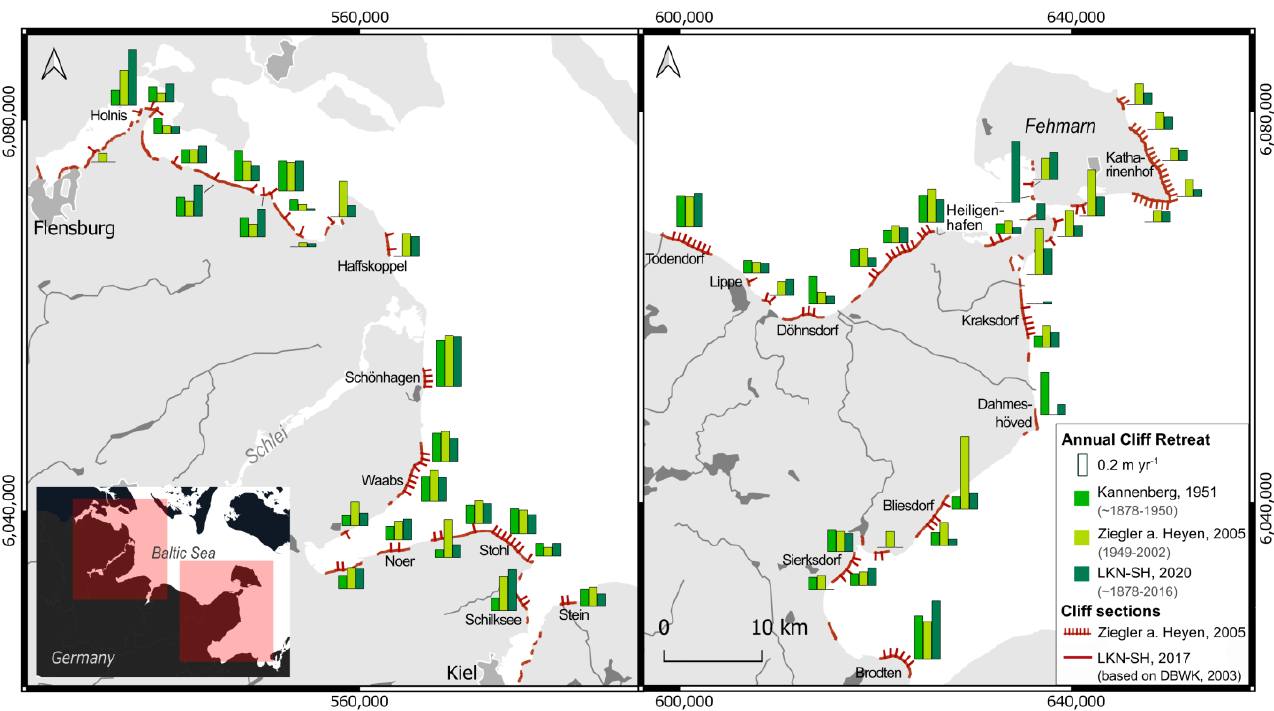
Figure 2. Annual cliff retreat (m yr −1 ) based on study results of Kannenberg [8], Ziegler and Heyen [36], and unpublished data from LKN-SH [52]. Detailed values in Table A1.